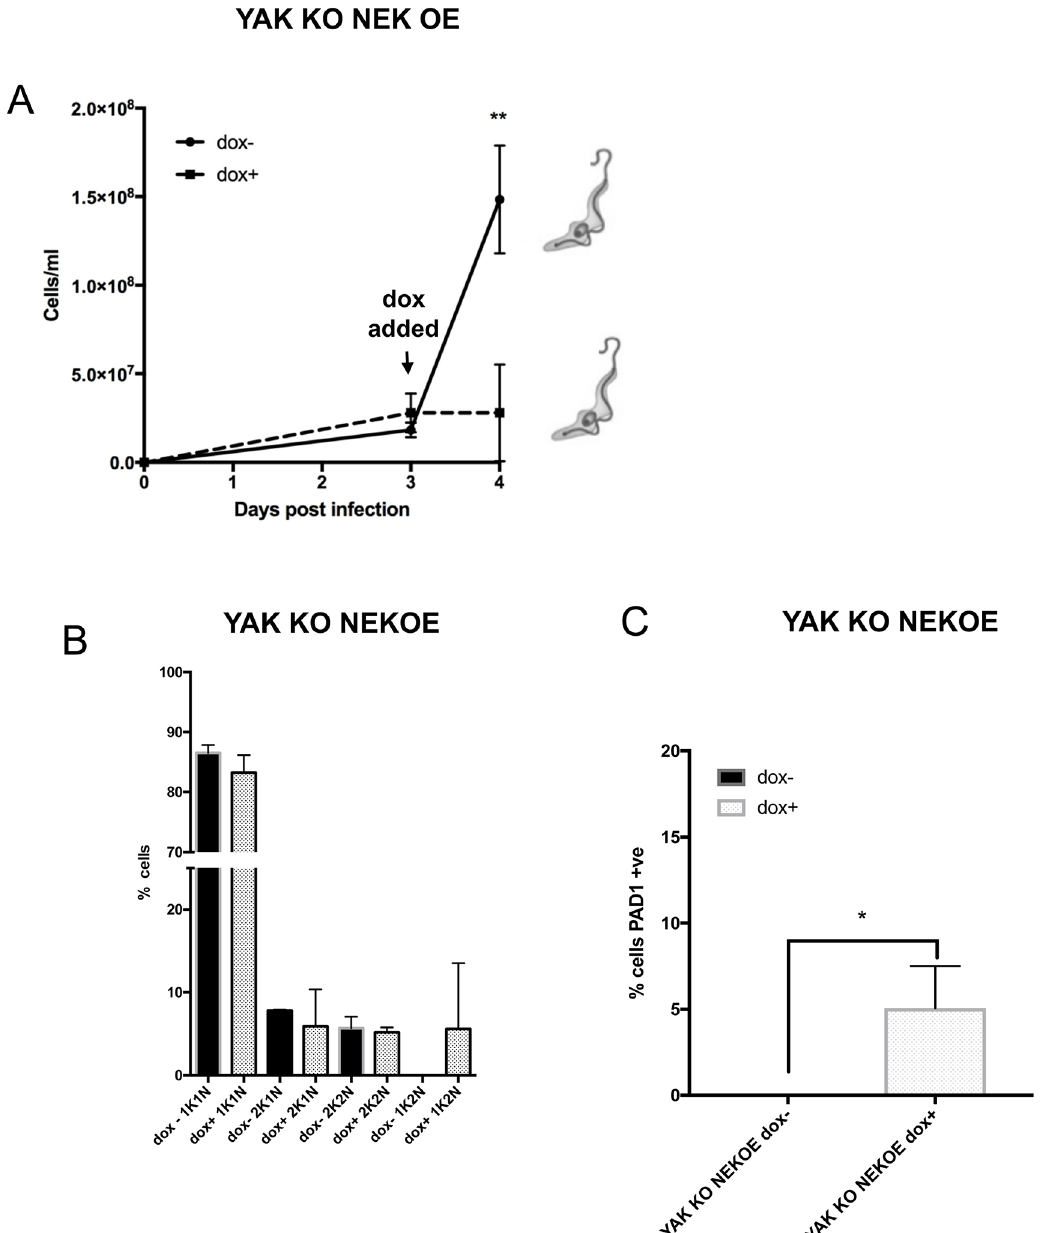
Fig 7. NEK17 induced differentiation is dependent on YAK. A. Growth in vivo upon inducible ectopic expression of NEK17 in the YAK null mutant. Induced (+dox; ■ ), uninduced (-dox; ● ) over 4 days growth, with doxycycline added on day 3 post infection. A schematic of the dominant morphology of each parasite population is shown. B. % 1K1N, 2K1N, 2K2N and the aberrant 1K2N cells upon inducible ectopic expression of NEK17 in the YAK null mutant at day 4 post infection. The data represents the mean and standard deviation of 250 cells counted at each time point in each infection. C. % PAD1 cells upon inducible ectopic expression of NEK17 in the YAK null mutant at day 4 post infection ( (cid:3) p < 0.05). 38.4 ± 7.6% PAD1+ve cells, whereas TbTOR4 RNAi in the MEKK null mutant at the same time point, few (11.2±2.2%) cells were PAD1 +ve (Fig 8C). A similar phenomenon was observed on day 5 of infection ( TbTOR4 RNAi induced in parental cells, 57.4±10.2%; TbTOR4 RNAi induced in the MEKK1 null mutant, 19.7±1.6%). Apparently therefore, Tb TOR4 depletion